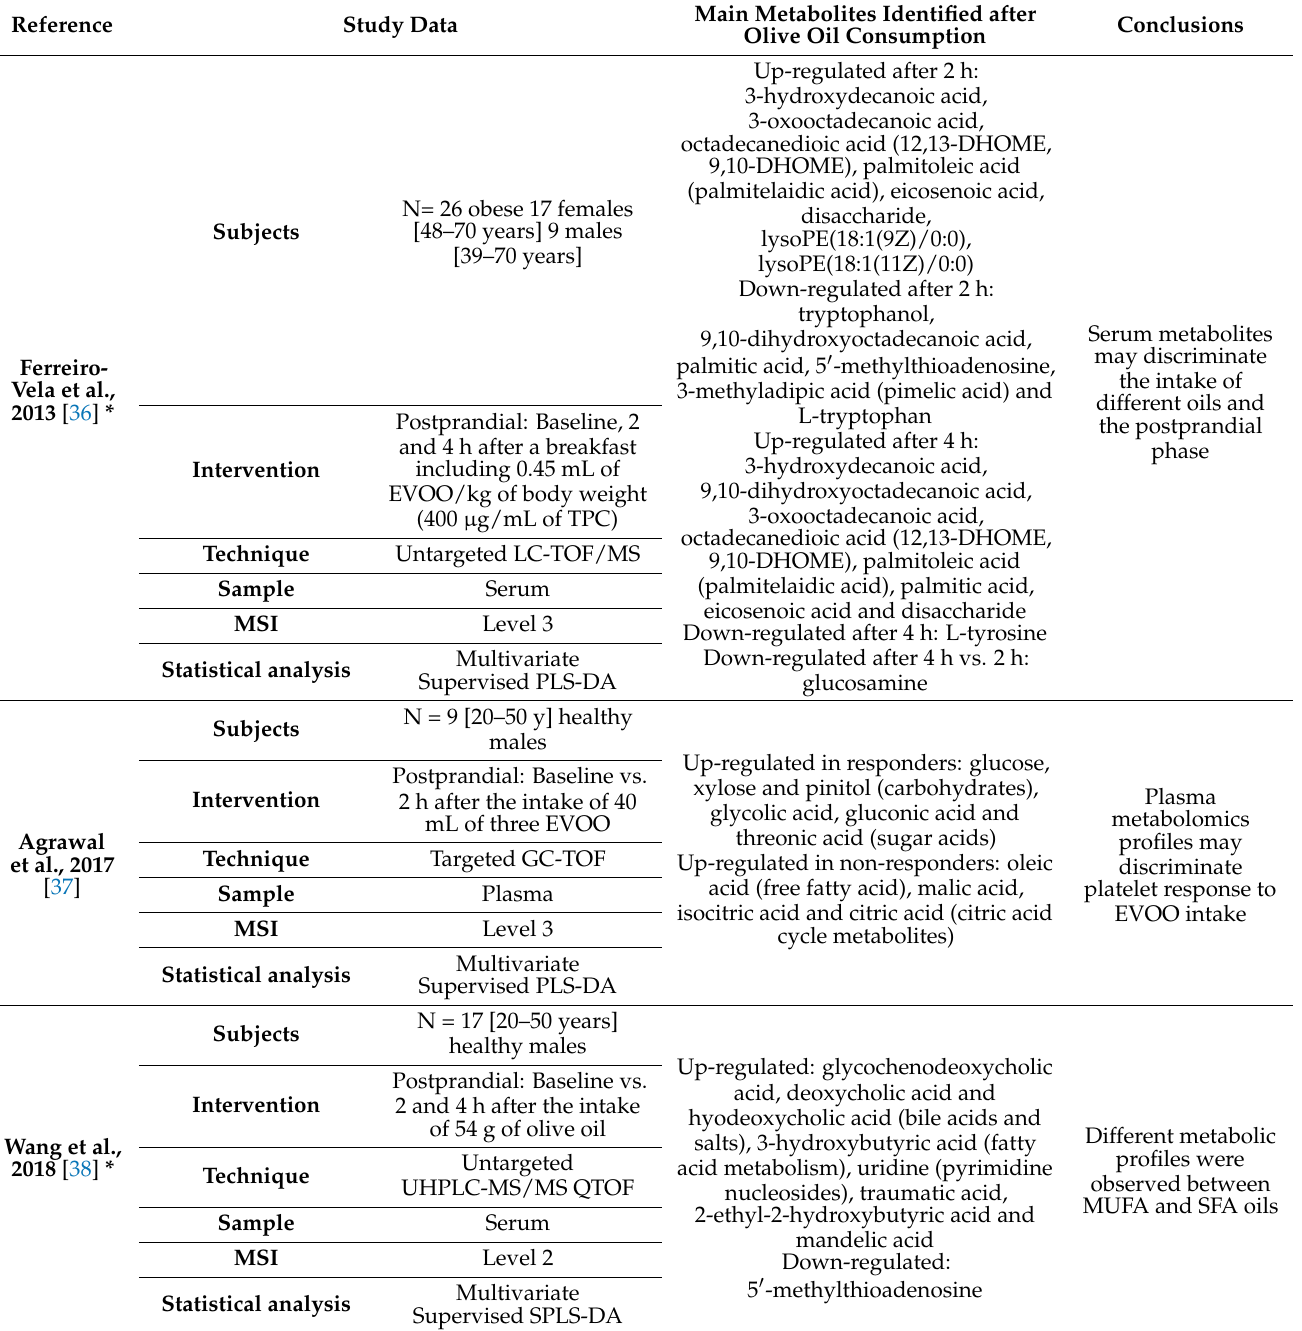
Table 2. Results of the main human postprandial metabolomics